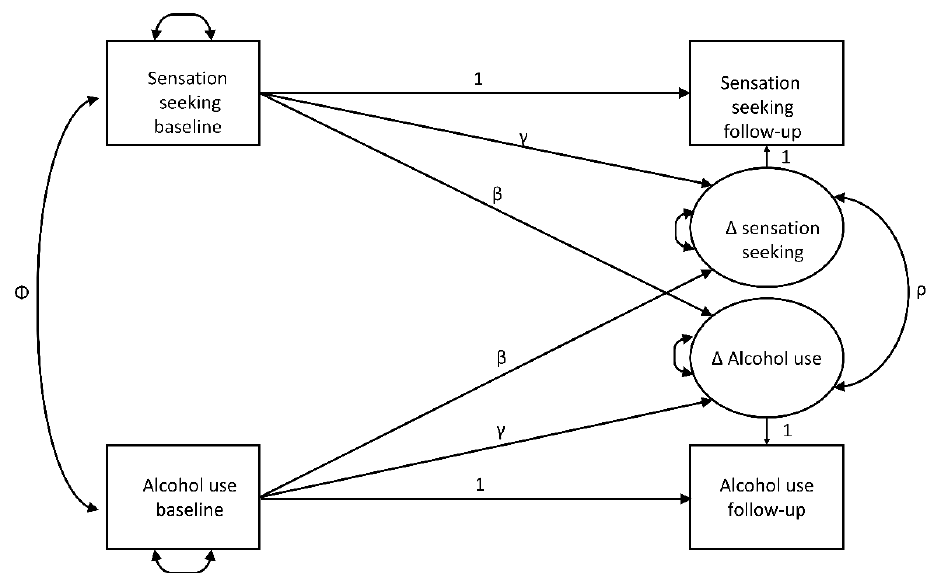
Figure 1. Theoretical Latent Change Score Model for Alcohol Use and Sensation-Seeking Traits. Note. Latent variables are drawn as circles. Manifest or measured variables are shown as squares. Residuals and variances are drawn as double-headed arrows into an object. Correlations are drawn as double-headed arrows between two objects ( Φ , ρ ). Paths ( β , γ ) are drawn as single-headed arrows. ∆ s represent the latent change scores. 1s are unstandardized paths are fixed to 1 for identifyability of the model. Means are omitted for visual clarity. Models were calculated for two alcohol variables (binge and volume) and sensation seeking as total scale and for the four subscales.